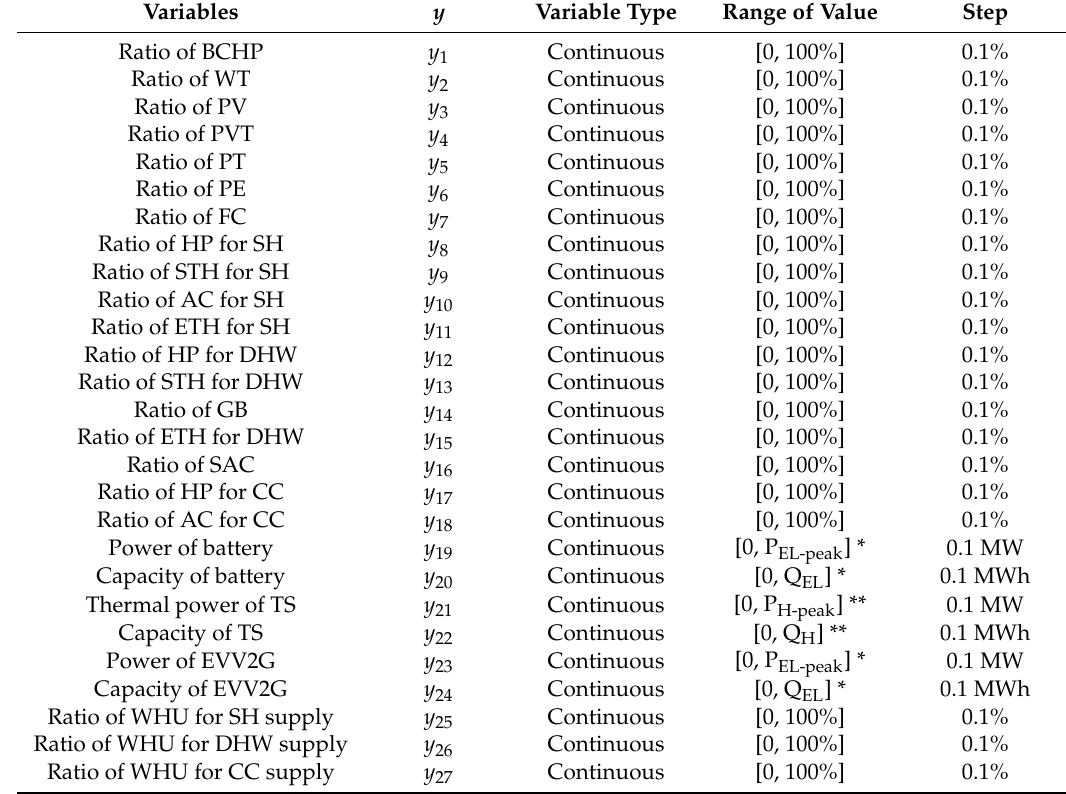
Table 1. Optimization variables